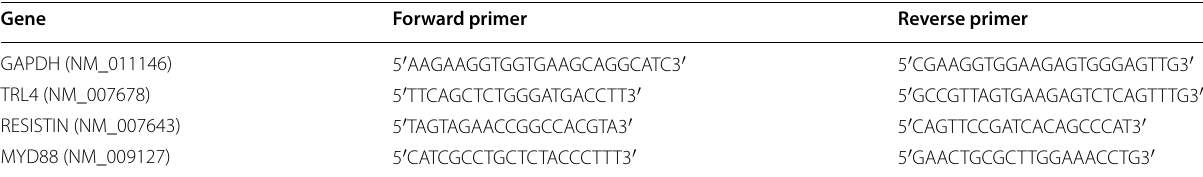
Table 1 Primers sequences used for Real-time PCR analysis